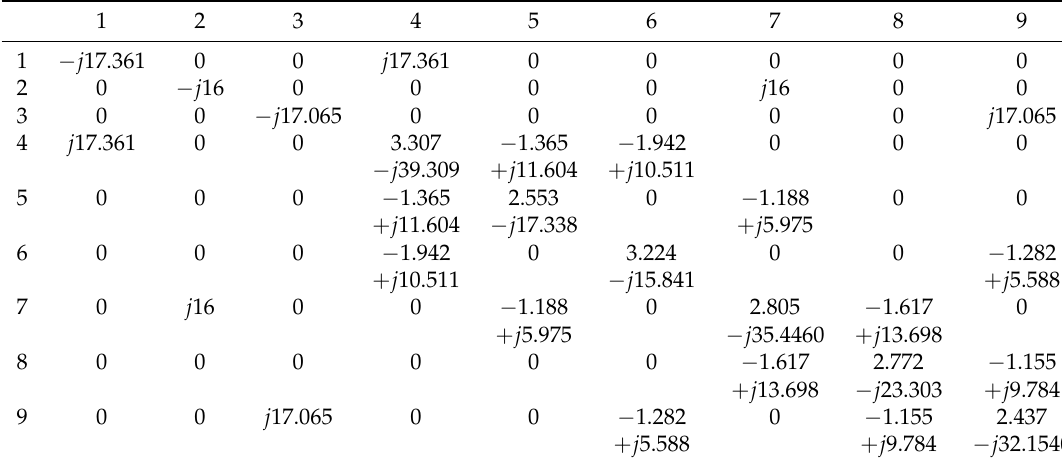
Table A1. Y sis for the 9-bus system.